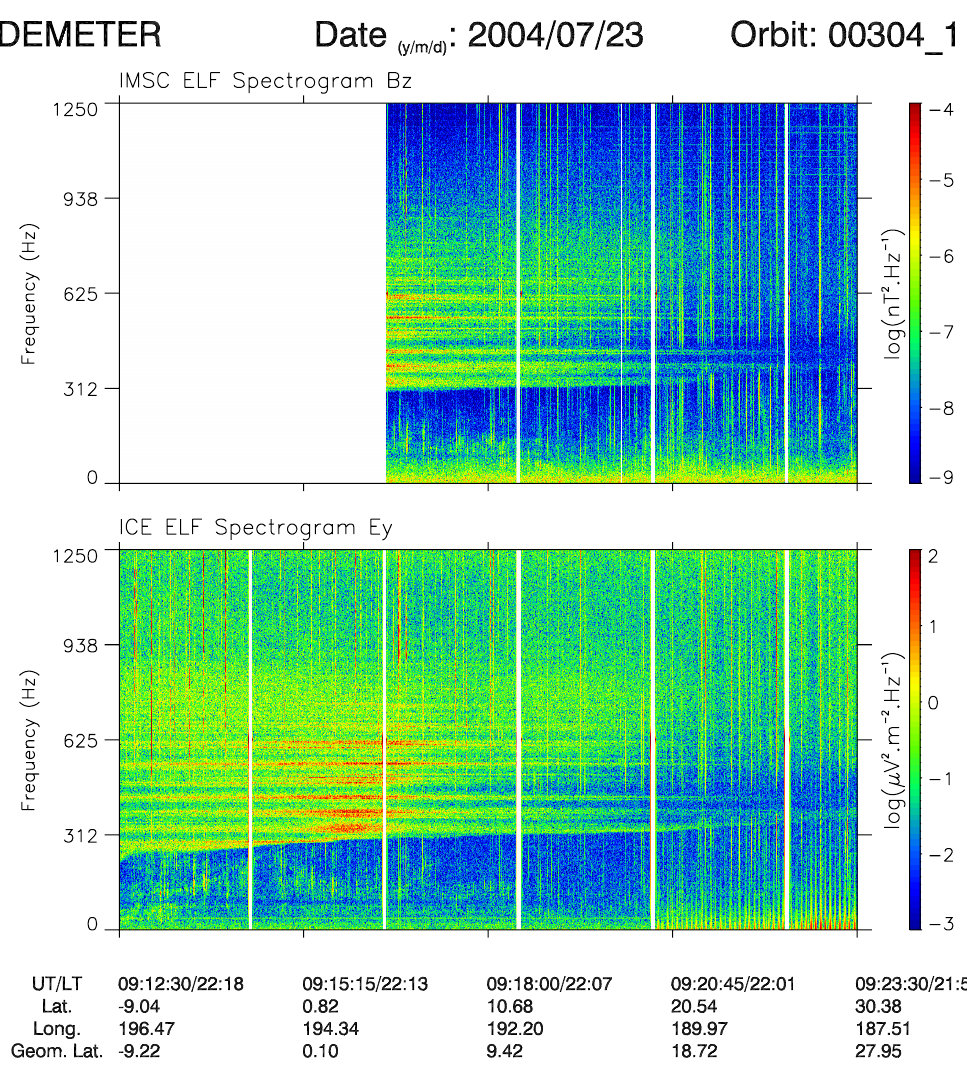
Fig. 1. Spectrograms of the magnetic component B x (top panel) and E y (bottom panel) recorded on 23 July 2004 (event 1). The intensity of the emissions is color-coded according to the color scale on the right. The vertical white lines indicate a change in the mode of the